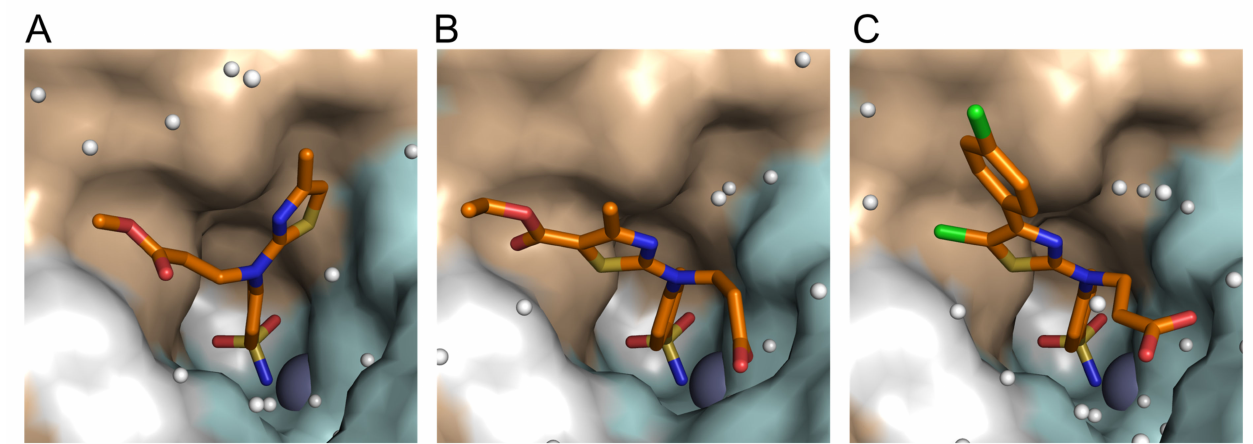
Figure 5. The X-ray crystallographic structures of ( A ) compound 28 (BB8.1-12) (PDB ID: 7QGZ); ( B ) compound 31 (BB8.1-4) (PDB ID: 7QGY); and ( C ) compound 36 (BB8.3-3) (PDB ID: 7QGX) in the active site of CAII. The zinc ion is shown as a grey sphere and water molecules as small white spheres. The protein surface of CAII is colored brown for hydrophobic residues (A, G, V, I, L, F) and cyan for the residues with polar side chains (R, K, H, E, D, N, Q, T, S, C). The refinement statistics are provided in the Supplementary